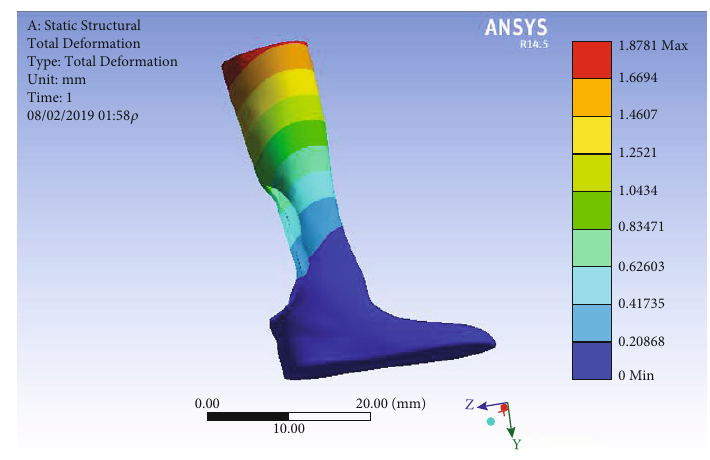
Figure 21: The total deformation in group